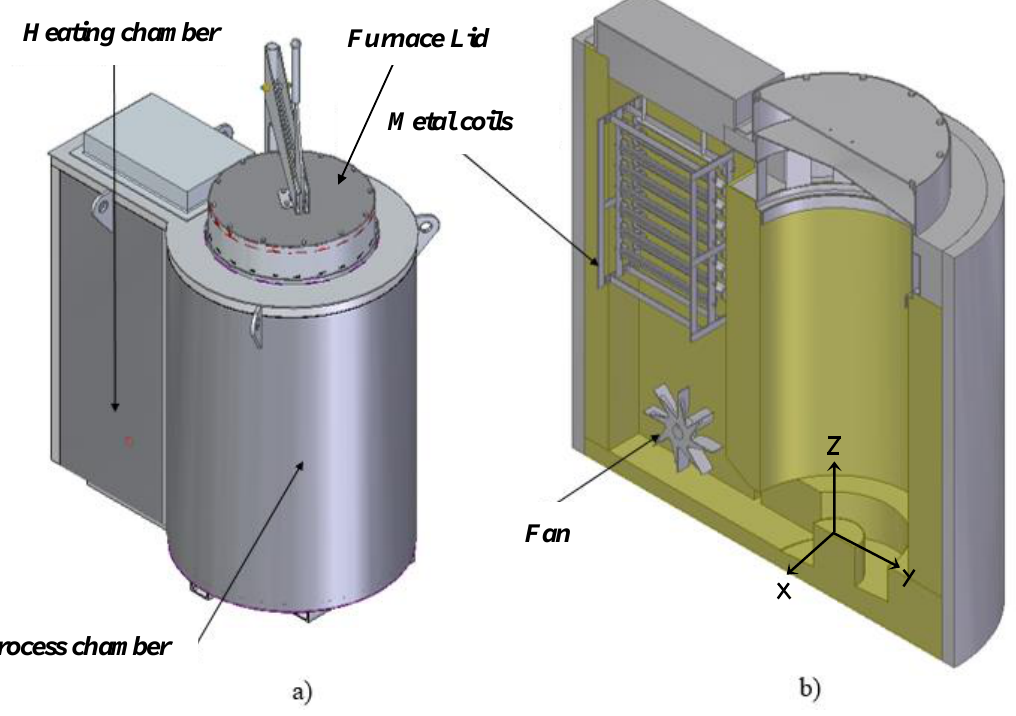
Figure 1. Tempering furnace studied in this work. ( a ) Isometric external view of the furnace and ( b ) cut view of the furnace with the coordinate system.